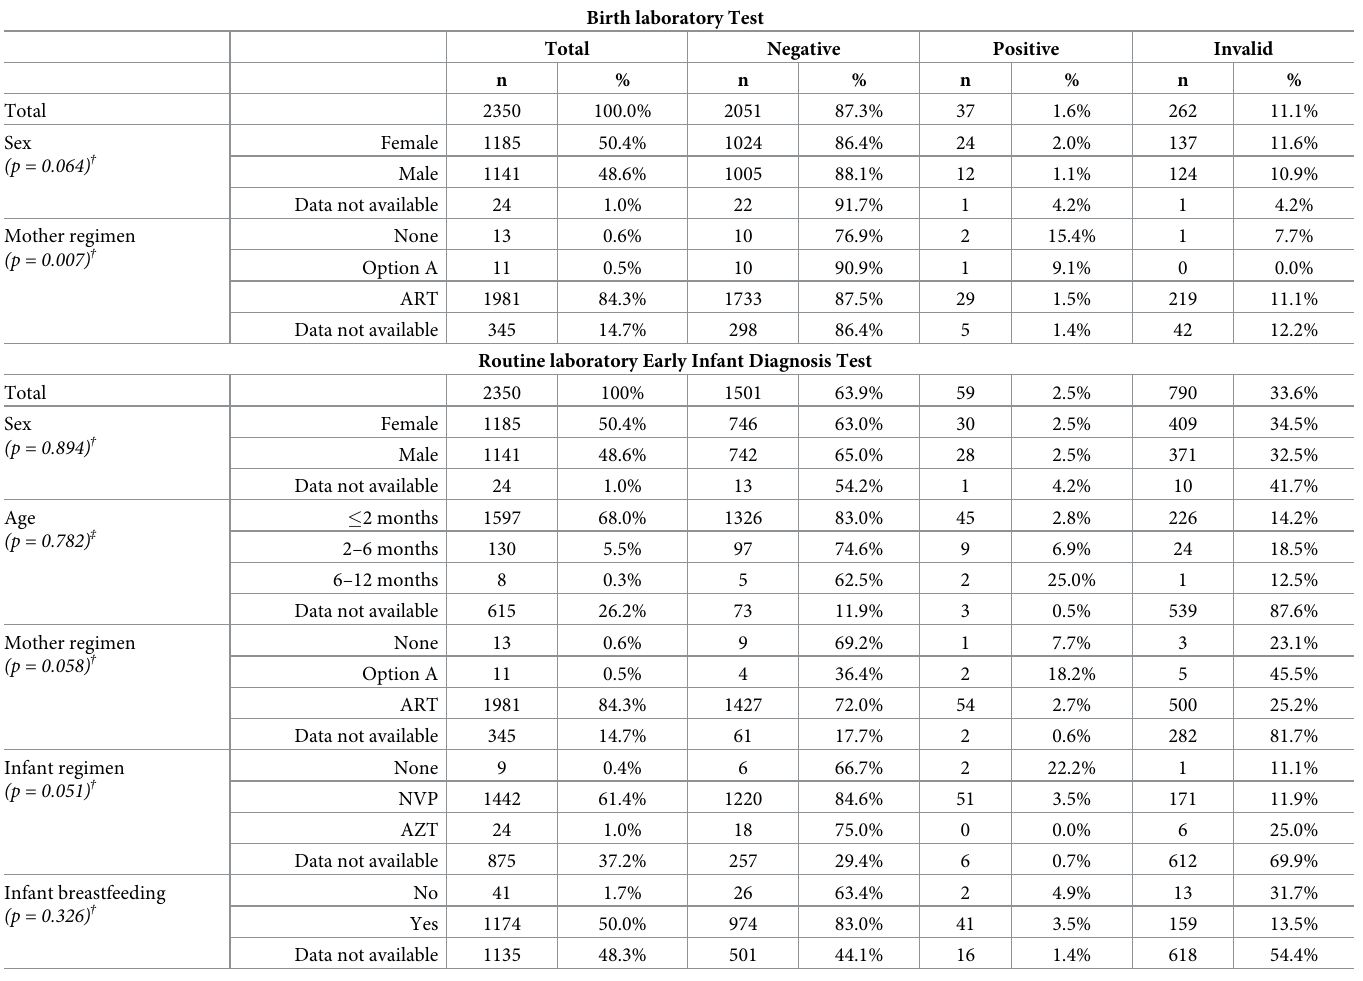
Fig 1. Flow diagram of participants at birth. POC = Point of Care, EID = Early Infant Diagnosis, Lab = laboratory test, POC Invalid = reported testing error, No Lab EID = poor quality or lost samples. https://doi.org/10.1371/journal.pone.0198344.g001 (Table 2). The positive and negative predictive values and overall agreement of POC testing at birth were 100% compared to laboratory testing, and Cohen’s kappa was 1 (cid:1) 000. Eleven percent of POC birth tests and 3 (cid:1) 1% of POC tests at 4–6 weeks did not produce a valid result due to test failure, while the rejection rate due to poor sample quality of laboratory dried blood spot specimens collected at birth and at 4–6 weeks was 9 (cid:1) 1% and 11 (cid:1) 2%, respec- tively (Fig 1). Four infant birth samples that tested positive with the laboratory test produced invalid results on the POC assay, while two infant birth samples that tested positive with the Table 1. Study population characteristics at birth and follow-up HIV testing at primary health clinics in